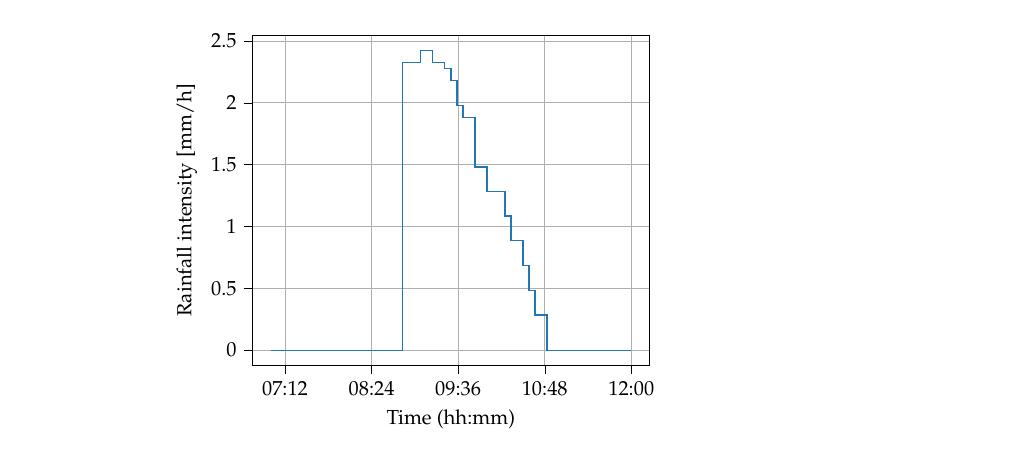
Figure A1. Precipitation data of the rain event used for evaluation state estimation and early